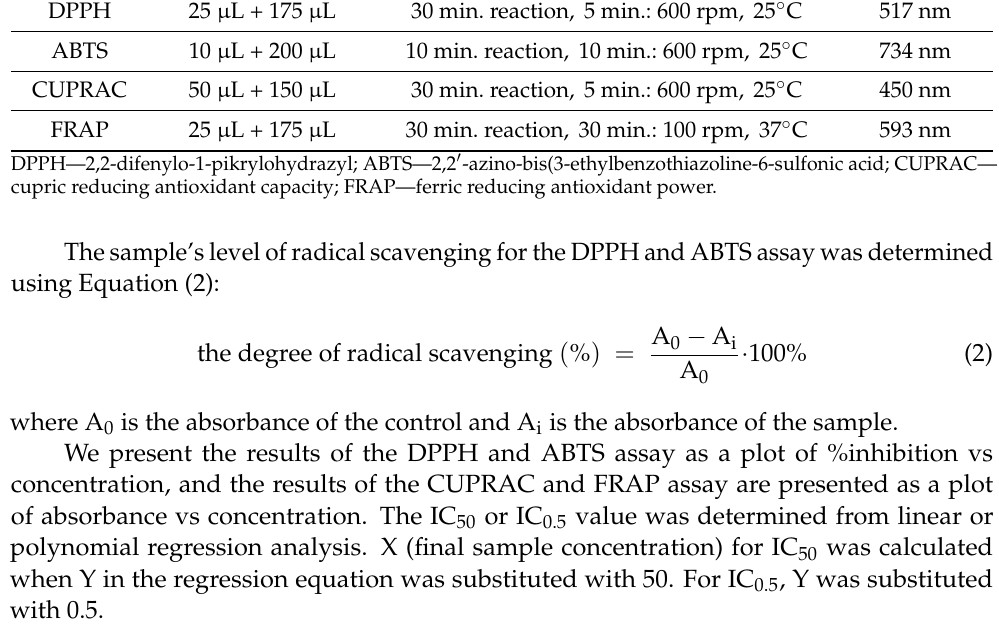
Table 2. The key parameters of DPPH, ABTS, CUPRAC, and FRAP effects. Sample Solution Method + Working Solution